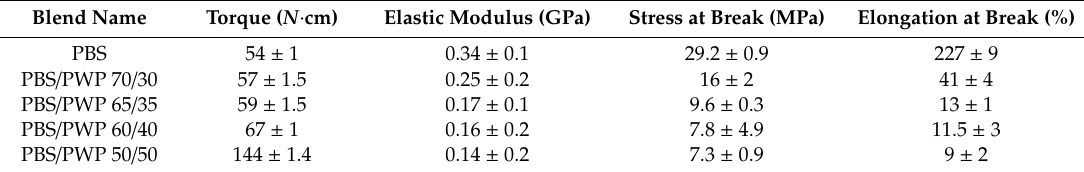
Table 1. Torque values and tensile properties of PBS-PWP first screening blends.